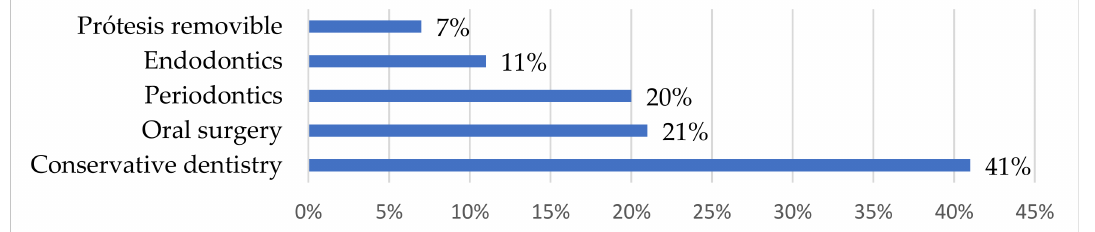
Figure 2. Types of treatments implemented.